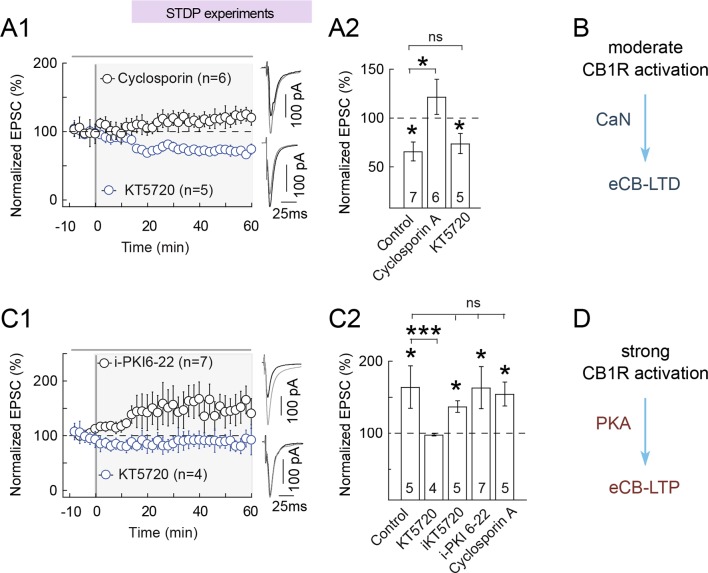
eCB-tLTP maintenance relies on presynaptic PKA activation.(A-B) eCB-tLTD is CaN-dependent. (A1) Summary
of plasticity induced by 100 pre-post pairings with bath applied KT5720
(1 μM) or with cyclosporin (1 μM). eCB-tLTD was prevented with CaN
(cyclosporin A) inhibition but unaffected with PKA inhibition (KT5720);
0/6 and 4/5 cells showed LTD with cyclosporin A and KT5720, respectively.
(A2) Summary bar graphs illustrate that eCB-LTD
maintenance involves the activation of presynaptic CaN by a
CB1R-triggered signal and was independent of the activation of
presynaptic PKA. (B) Main conclusion scheme: eCB-LTD is
triggered by moderate prolonged levels of CB1 activations and requires
active CaN. Normality was assumed for the cyclosporine A & KT5720
data (test not passed). (C-D) eCB-tLTP is PKA-dependent.
(C1) Summary of plasticity induced by 10 post-pre
pairings with bath applied KT5720 (1 μM) or with i-PKI6-22 (20 μM).
eCB-tLTP was prevented with bath-applied KT5720 but unaffected with
i-PKI6-22, a cell-impermeant PKA inhibitor applied intracellularly in the
postsynaptic neuron; 0/4 and 6/7 cells showed LTP with KT5720 and
i-PKI6-22, respectively. (C2) Summary bar graphs illustrate
that eCB-tLTP depends on presynaptic PKA activation since it was
prevented by bath-applied KT5720 but unaffected when KT5720 or PKI6-22,
was applied intracellularly in the postsynaptic neuron (i-KT5720,
i-PKI6-22). Cyclosporin A had no effect on eCB-tLTP, showing that it was
CaN-independent. Thus, eCB-tLTP maintenance involves the activation of
presynaptic PKA by a CB1R-triggered signal. Normality was assumed for the
ctrl & KT5720 data (test not passed). (D) Main
conclusion scheme: eCB-LTP is triggered by large levels of short duration
of CB1R activation and requires presynaptic active PKA. Representative
traces are the average of 15 EPSCs during baseline (black traces) and 50
min after STDP protocol (grey traces). Error bars represent SD.
*p<0.05. ns: not significant.